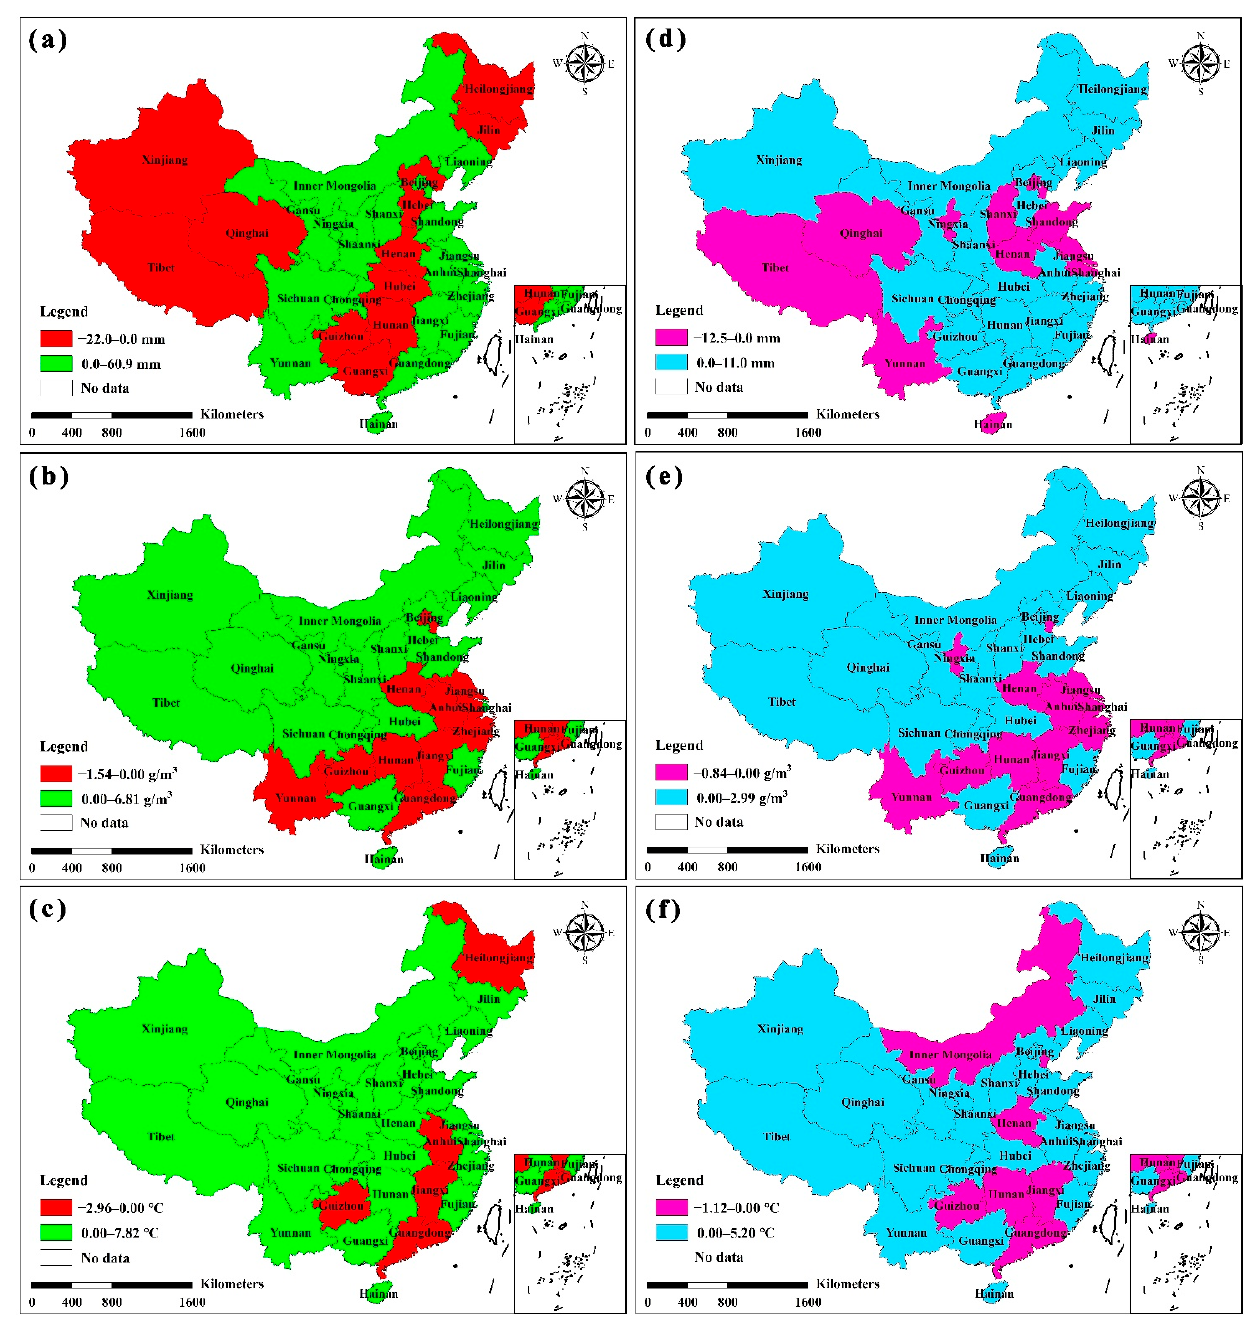
Figure 6. Spatial distribution comparison of precipitation ( a , d ), absolute humidity ( b , e ), and temperature ( c , f ) between urban and suburban areas during summer (left column) and winter (right column; 2010–2019).